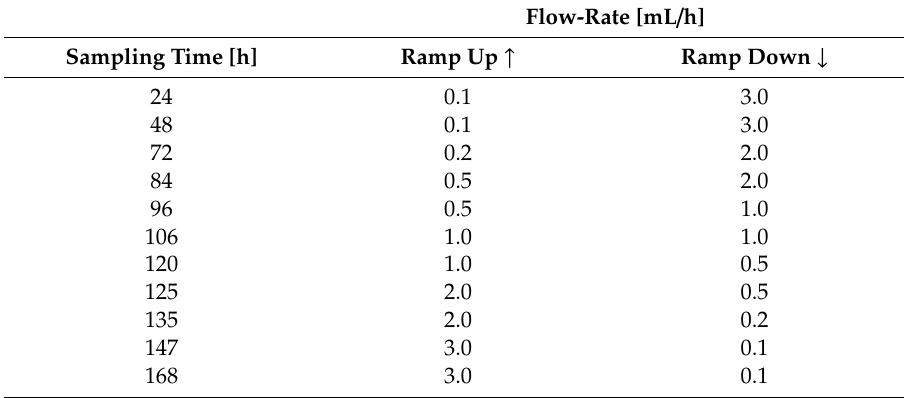
Figure 1. Dissolution setup. The reservoir for the physiological fluid was controlled at 37 °C, as well as the flow-through cells. The peristaltic pump regulated the flow-rate of up to eight cells in parallel, with a programmable autosampler for fluid collection. The flow-through cell was equipped with 5 kDa membranes to hold back particles and only allow the flow of ions. The meniscus of the reservoir was elevated approx. 0.5 m above the cells such that the hydrostatic pressure balanced the pressure drop by the 5 kDa membrane. Table 1. Ramped flow-rates in dependence of time. Ramp up describes an increasing flow-rate from 0.1 to 3 mL/h, and ramp down describes a decreasing flow-rate from 3 to 0.1 mL/h.